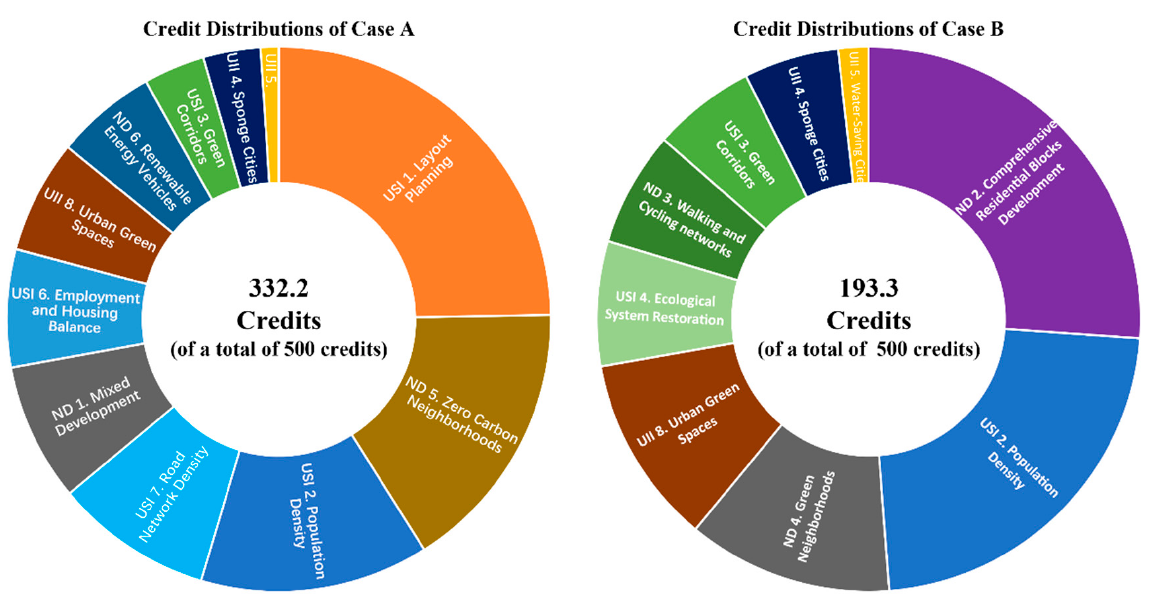
Figure 7. Credit distributions of Case A and Case B. Table 11. Credits acquired for Case A and Case B.